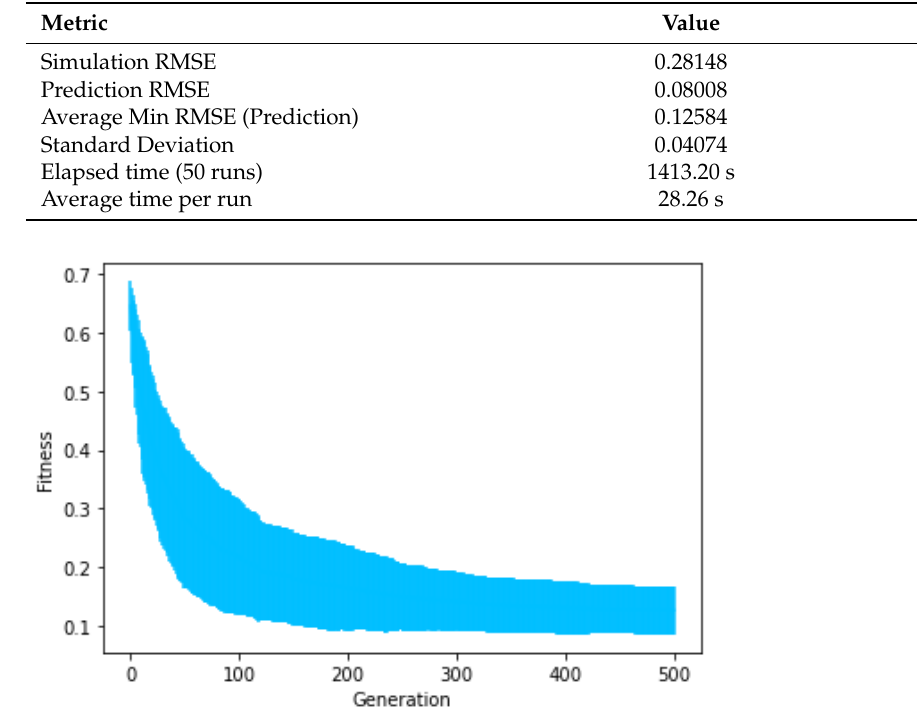
Figure 12. Average minimum fitness and error bars (prediction RMSE) for the Coupled Drives